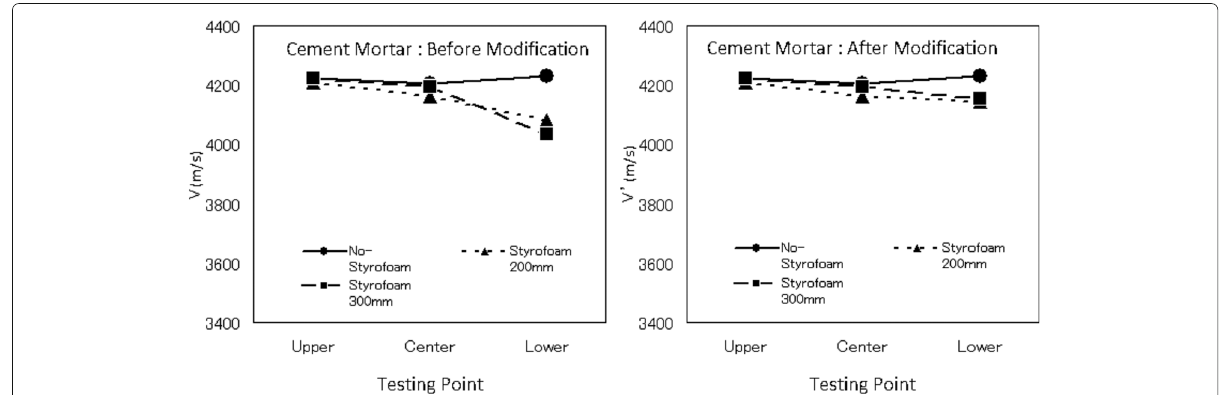
By Conclusion 3.1, what we can obtain by observation is the travel time of the ultrasonic wave which propa- gates along the route where the travel time would be the shortest in (cid:5) , which is what is meant in (5). If we can reconstruct f ( x ) , ( x ∈ (cid:5)) out of the data (5), then we can concretely reconstruct the interior of the concrete struc- tures in a non-destructive way. Let us summarize this argument as